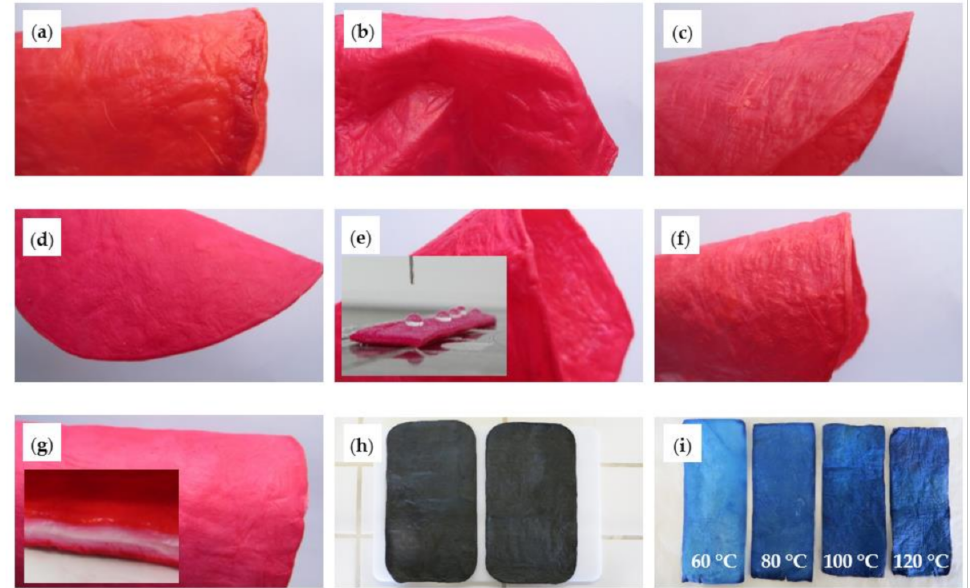
Figure 4. Photos of the dyed BC composites. Letters ( a – i ) correspond to the experimental conditions described in Section 2.3.2. Simultaneous dyeing and production of the BC-based composites ( a – f ) and dyeing of dry composites ( g – i